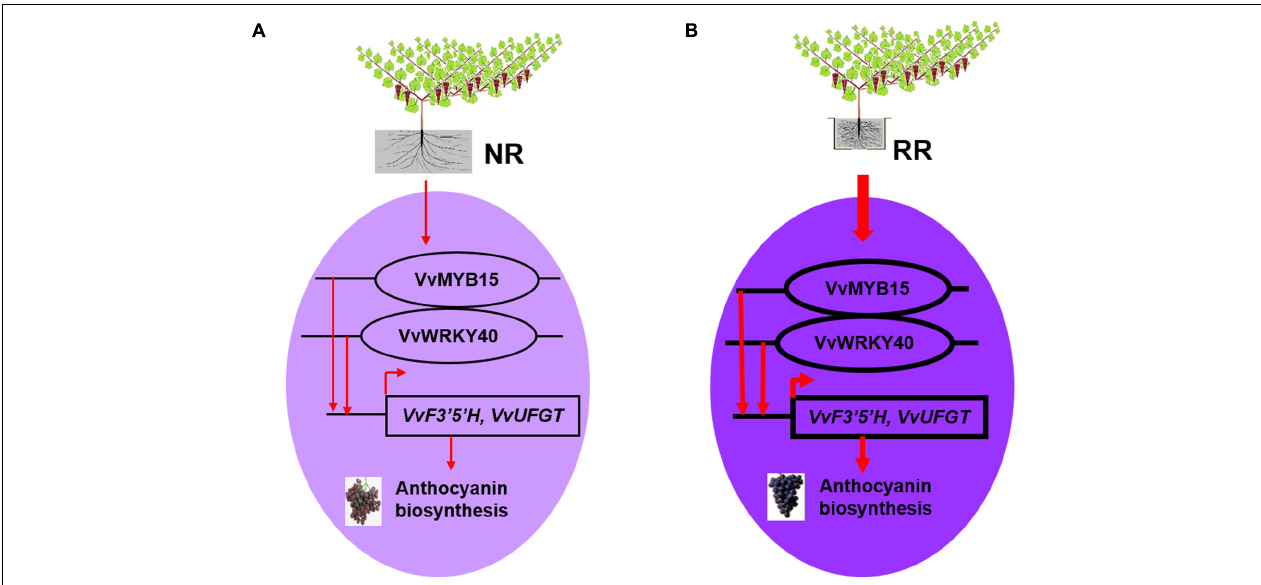
FIGURE 7 | A model of VvMYB15 and VvWRKY40-modulated biosynthesis of anthocyanin under root restriction in grape berries. (A) In the absence of root restriction, the expression profile of VvMYB15 and VvWRKY40 in grape berries were relatively lower, therefore, the regulatory effect on the downstream anthocyanin biosynthetic genes ( VvF3 (cid:48) 5 (cid:48) H , VvUFGT ) was relatively lower, the anthocyanin content of grape berries was relatively lower. (B) In the presence of root restriction, the expression level of VvMYB15 and VvWRKY40 were significantly increased, at the same time, VvMYB15 and VvWRKY40 could form heterodimer that binds the promoter of VvF3 (cid:48) 5 (cid:48) H and VvUFGT and activate their expression, which contributed to the accumulation of anthocyanin in grape berry. The thicker the arrow, the higher level of the gene expression; the thinner the arrow, the lower level of the gene expression. Purple indicates the higher anthocyanin content, whereas light purple indicates the lower anthocyanin